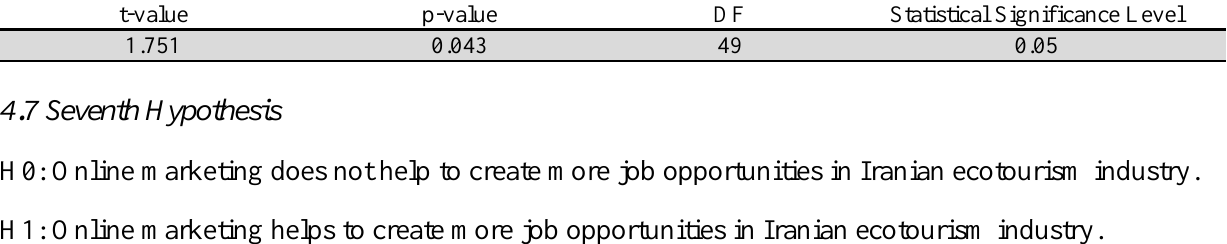
Sixth hypothesis at 95% confidence level t-value p-value DF Statistical Significance Level 1.751